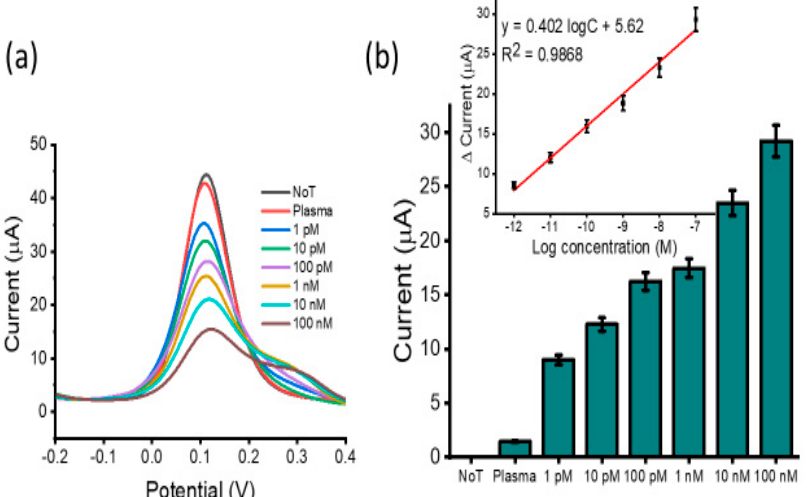
Figure 5. Assay testing in spiked plasma samples: ( a ) DPV readout displaying current output for serially diluted HOTAIR lncRNA in spiked plasma from 1 pM to 100 nM in reference to the NoT and ( b ) change in DPV current response for serially diluted HOTAIR targets in response to the NoT with linear calibration plots (inset). Error bars represent the standard deviation across three separate experiments.